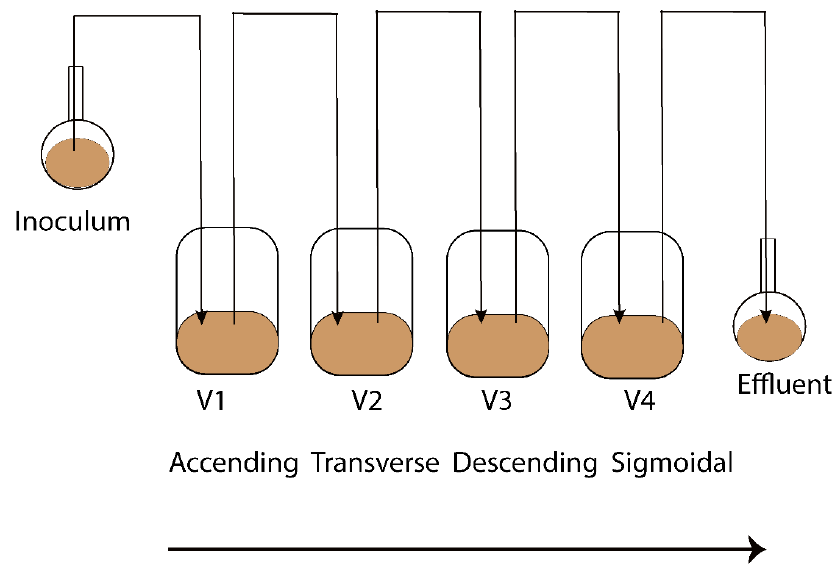
Figure 1. Schematic representation of the Enteromix simulated colon model. The vessels in one unit (V1–V4) simulate the different compartments of the human colon from the proximal to the distal part, each having a different controlled pH and flow rate. The whole unit is maintained anaerobically and at 37 °C. See [13] for more details. A total of 44 samples were gathered from vessels (V1–V4) of the in vitro colon simulator and were kept at −80°C until lipidomics analysis. These samples were obtained from 11 simulations, each involving four vessels. Among these simulations, eight were conducted for 48 h, while three were conducted for 24 h.